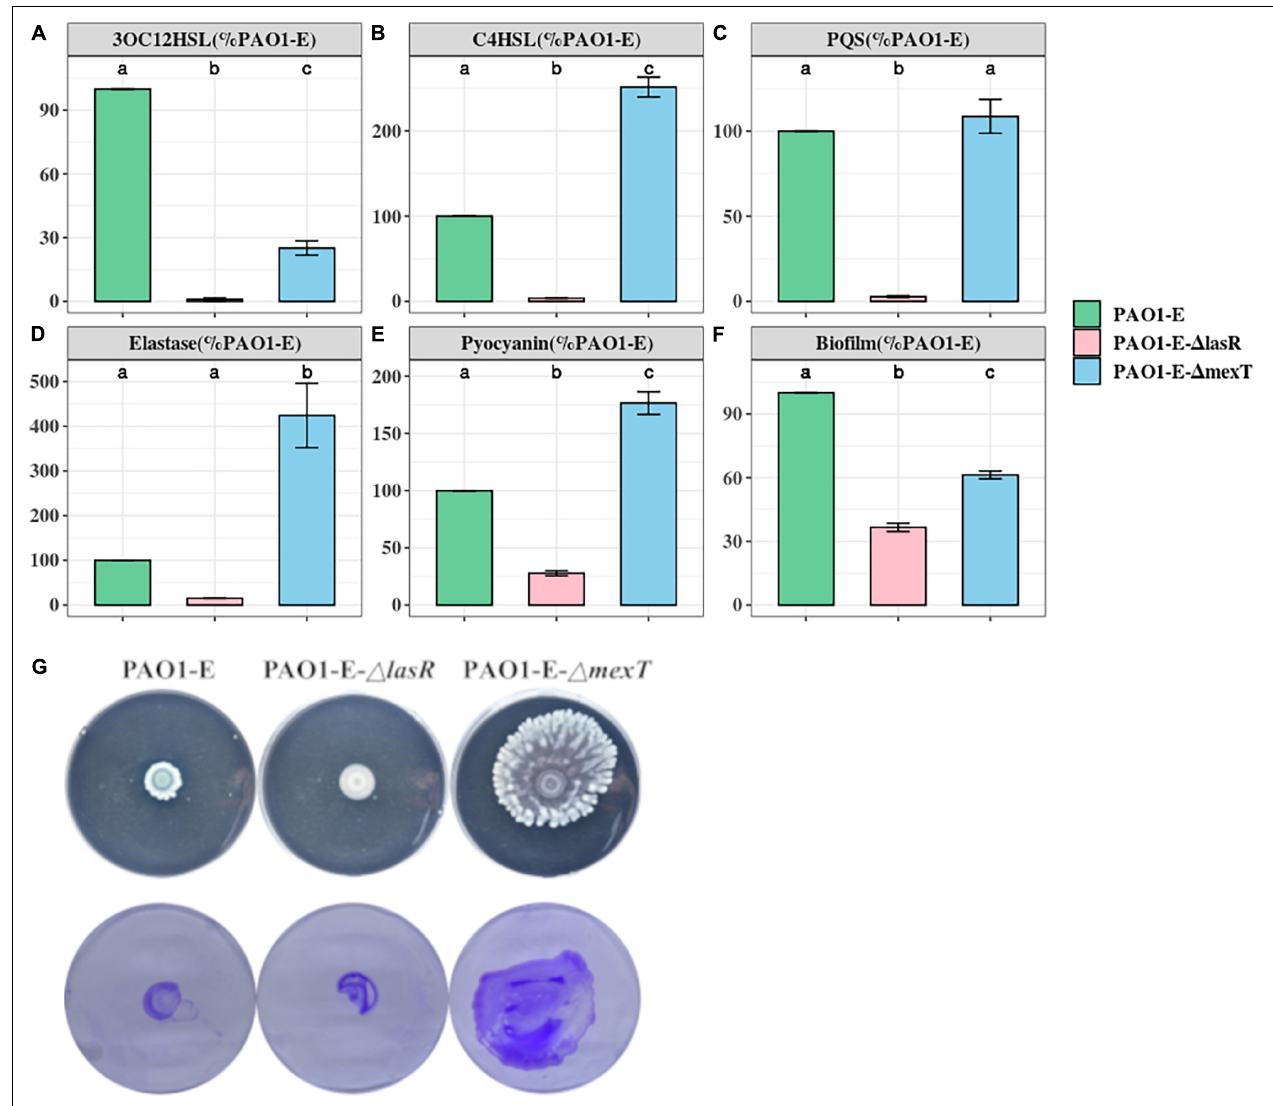
FIGURE 4 | Quorum sensing signal and Virulence production in PAO1-E derivatives. (A–F) Assay were performed with strains grown for 16 h in LB medium. The amount of signal and virulence produced by PAO1-E was arbitrarily set at 100%. (G) Swarming motility (top) and crystal violet stained twitching motility (bottom) of the